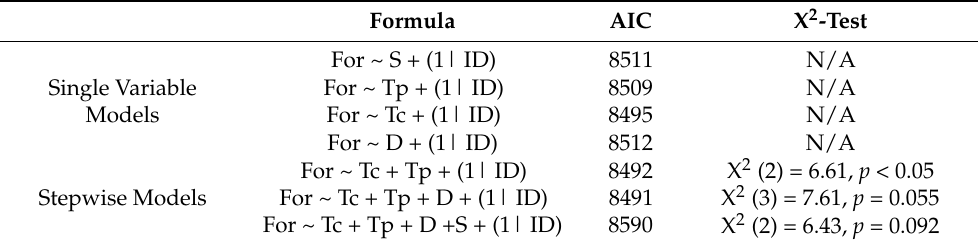
Table A4. Stepwise model selection for Shannon Airport. Details see Table